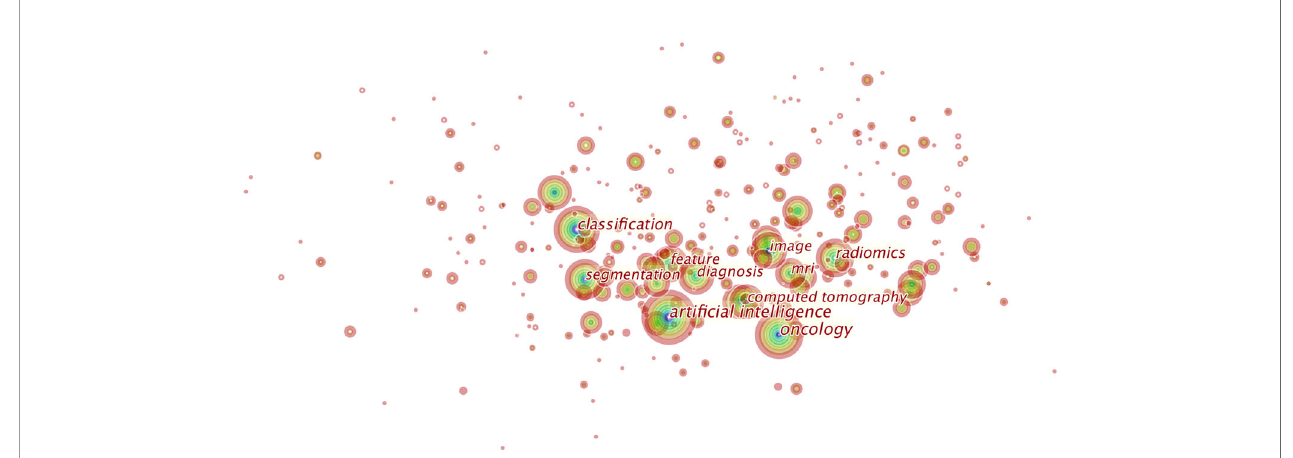
FIGURE 7 | This is the knowledge map of the most cited keywords in this fi eld. Each node represents a keyword, and the sizes of rings on the node denote the number of publications related to the keyword in a certain year. This map suggests the hotspots in this research fi